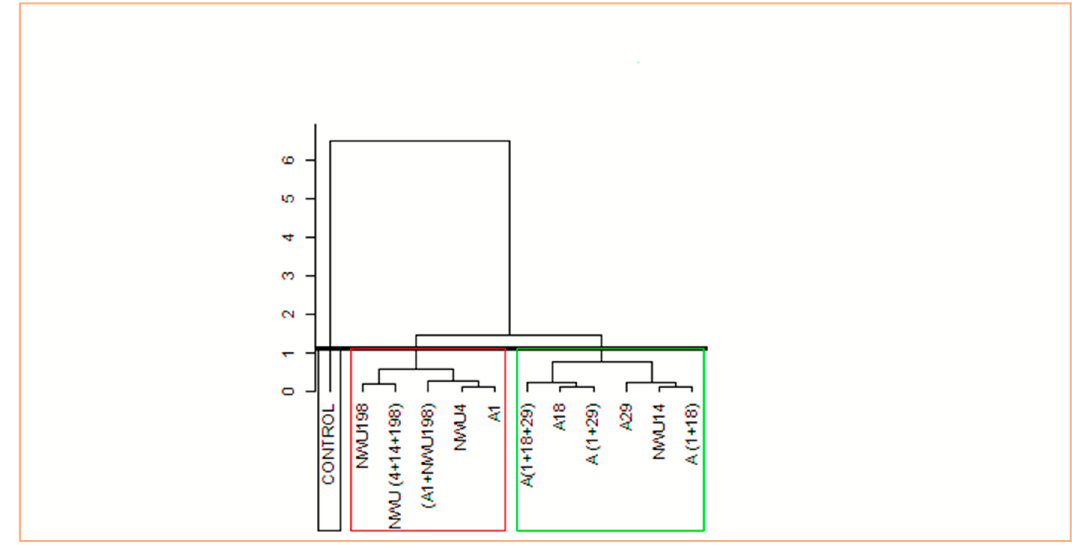
Figure 6. Hierarchical clustering of the treatments on growth parameters.